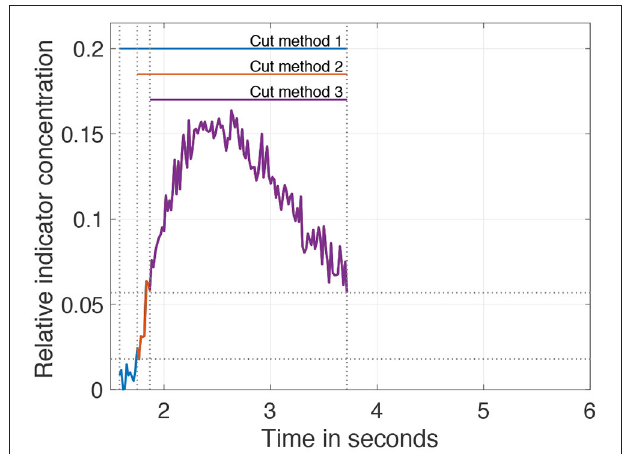
FIGURE 5 | Visualization of the three different pre-processing (cutting) methods on the data. The cut level is set to 40 % of the maximum. After applying cut method 3, the purple curve remains. Applying cut method 2 results in the curve consisting of purple and red. Application of cut method 1 results in the curve of all three colors purple, red, and